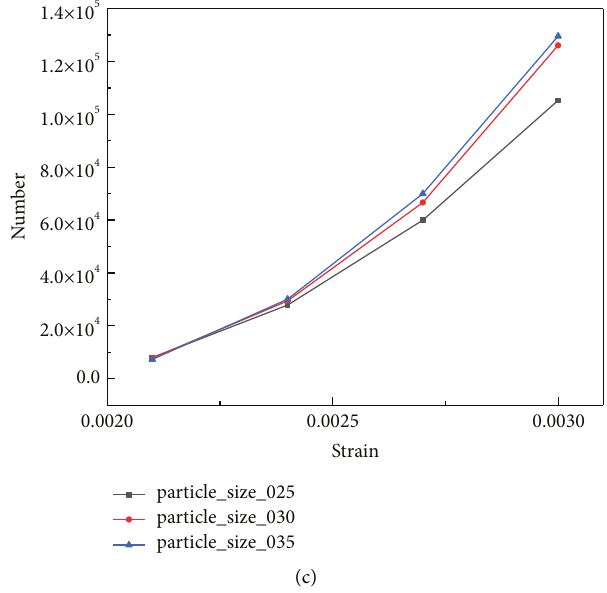
Figure 13: Number of units with tensile damage factor greater than 0.7. (a) Overall stage, (b) rising stage, (c) falling stage.